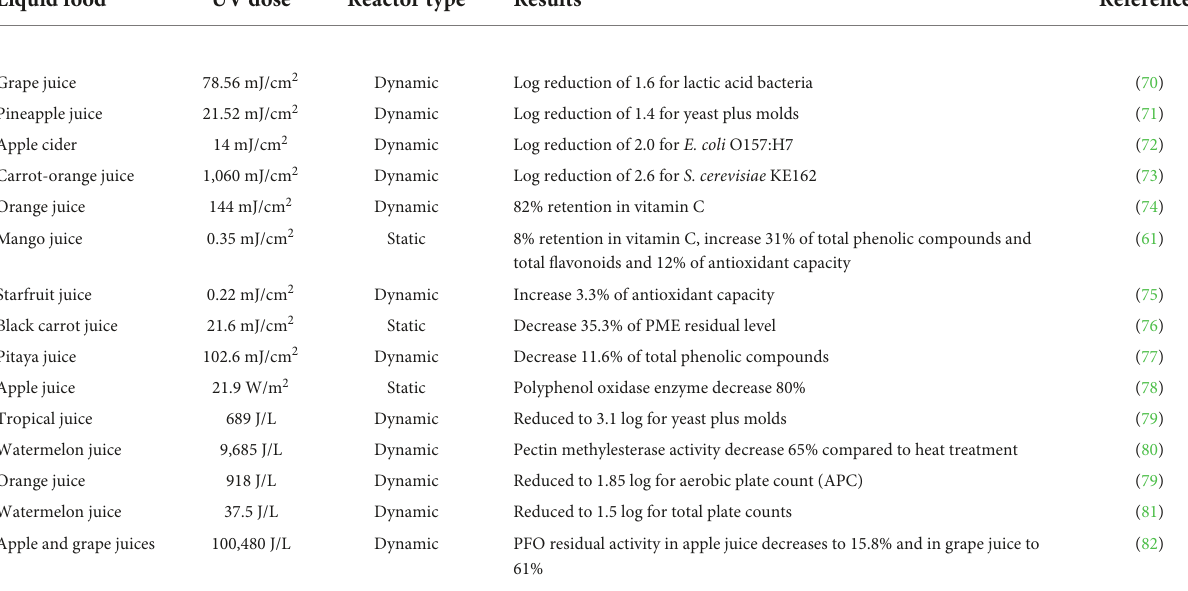
TABLE 1 Summary of studies related to ultraviolet (UV-C) processing of liquid fruit and vegetable-based